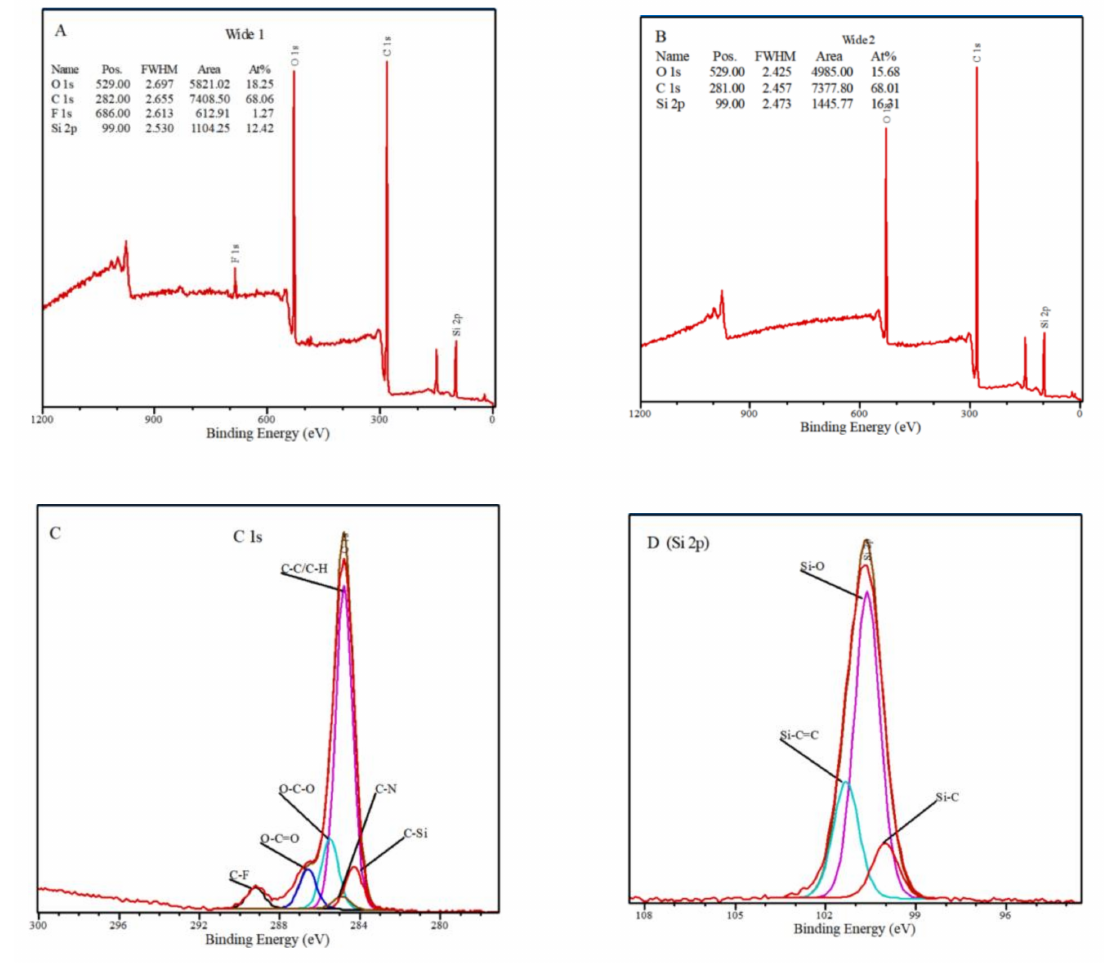
Figure 5. XPS spectra of the PFMPUAs coating: ( A ) wide 1 scanning; ( B ) wide 2 scanning; ( C ) C 1s; ( D ) Si